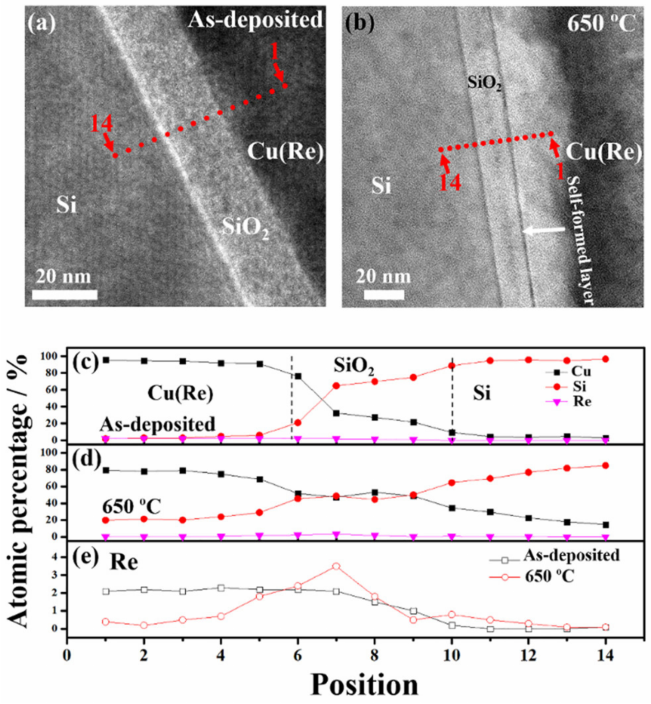
Figure 4. The positions of STEM-EDX testing of the ( a ) as-deposited sample and ( b ) sample annealed at 650 ◦ C. The component distribution of the Cu(Re) film in the ( c ) as-deposited and ( d ) 650 ◦ C anneal- ing conditions. ( e ) The profile composition of Re for the as-deposited sample and Cu(Re)/SiO 2 /Si sample annealed at 650 ◦